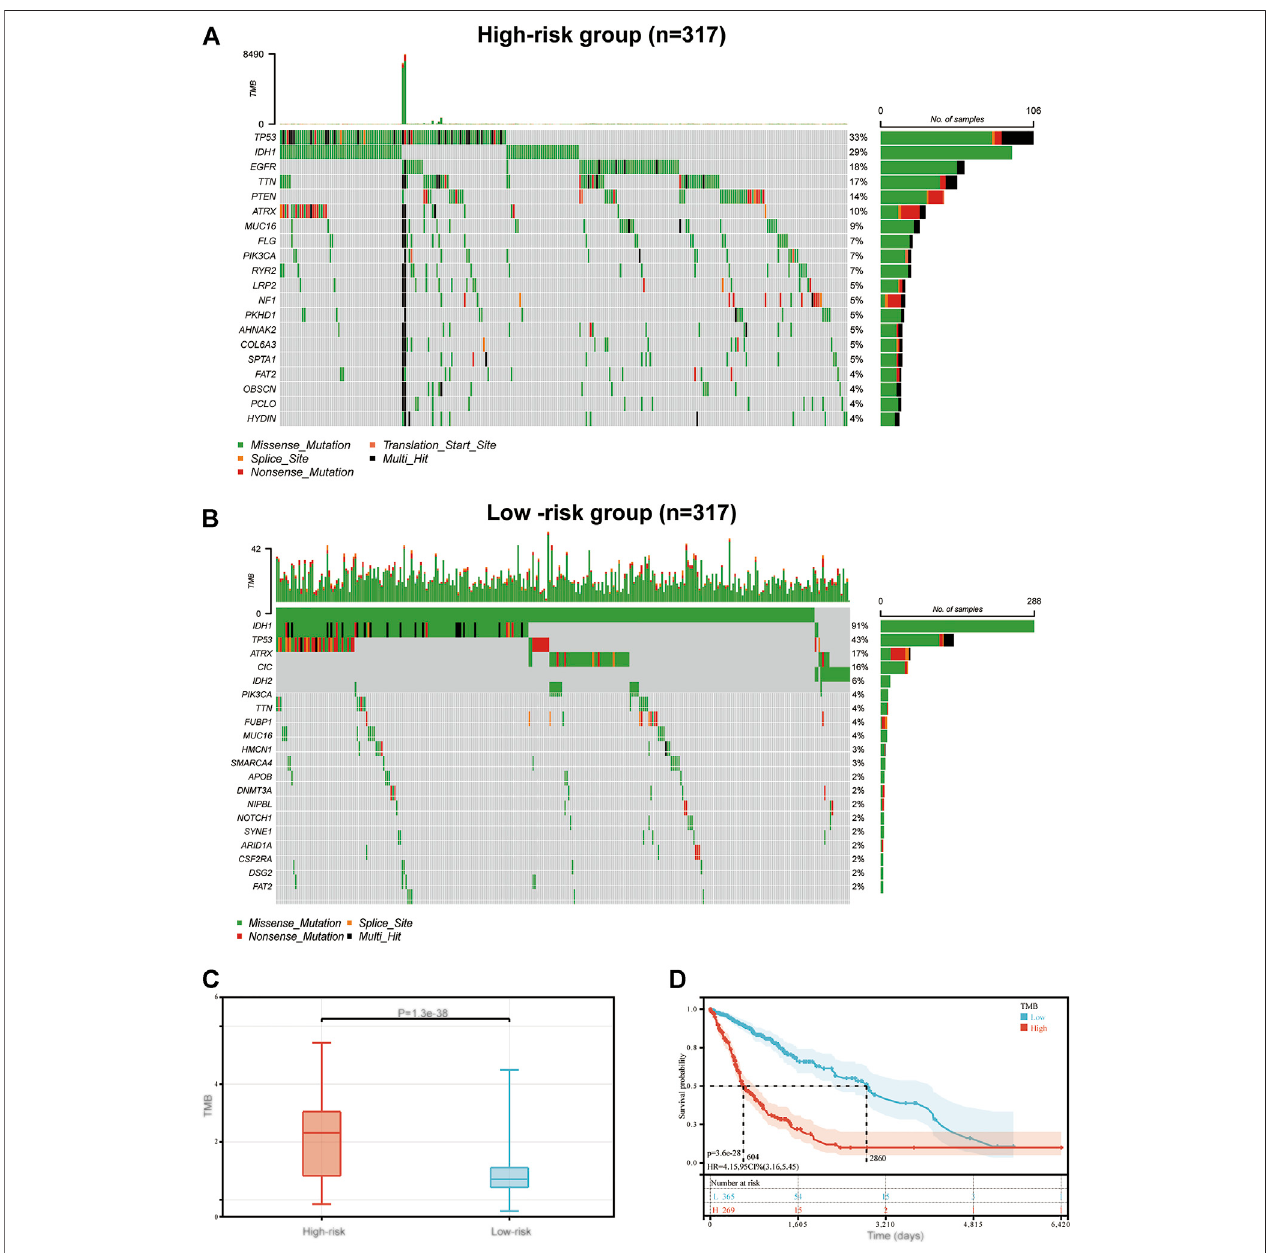
FIGURE6| Themutationpro fi leandTMBinlow-riskandhigh-riskgroups.Mutationpro fi lein (A) high-riskand (B) low-riskgroups. (C) Theassociationbetweenthe immune-relatedsignatureandTMB. (D) TheassociationbetweenTMBandOSintheTCGAGBMandLGGdatasets.TMB,tumormutationburden;OS,overallsurvival; TCGA, The Cancer Genome Atlas; GBM, glioblastoma multiforme; LGG, low grade glioma.